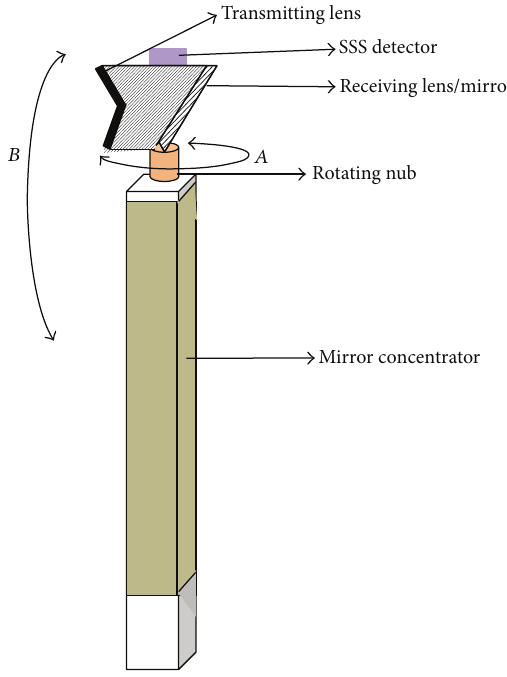
Figure 13: Pictorial model of a concentrator